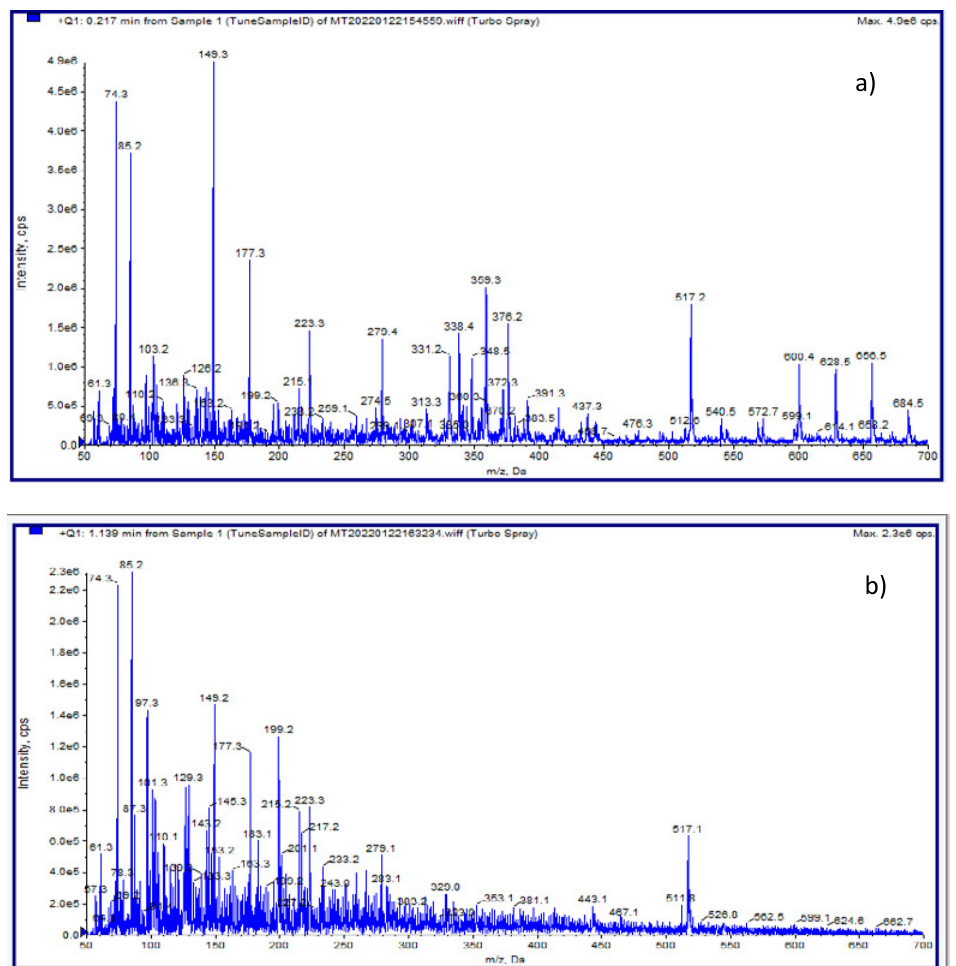
Fig. 9. LC-MS analysis of Nigrosine dye a) before and b) after